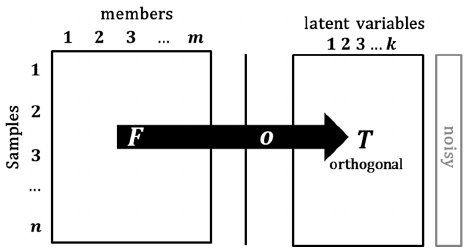
Figure 1. The schematic plot of Partial Least Squares Regression (PLSR). F is the matrix for forecast data of selected members (predictors) and o is the vector of tropical cyclone position (a response). PLSR deprives T , referred to as latent variables, of F maximizing correlation with o . The noisy matrix is not used for calculating unequal